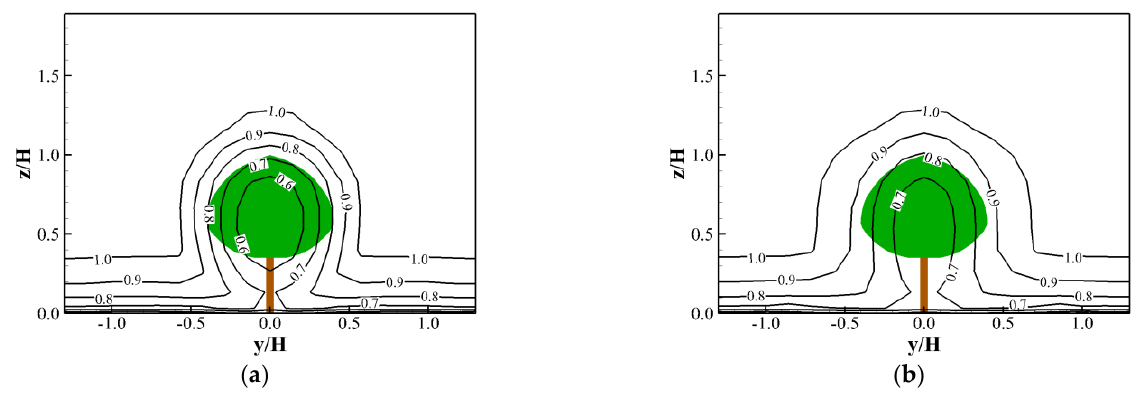
Figure 8. Predicted mean velocity profiles at ( a ) x = 3 H and ( b ) x = 4.5 H (C Da = 0.86).